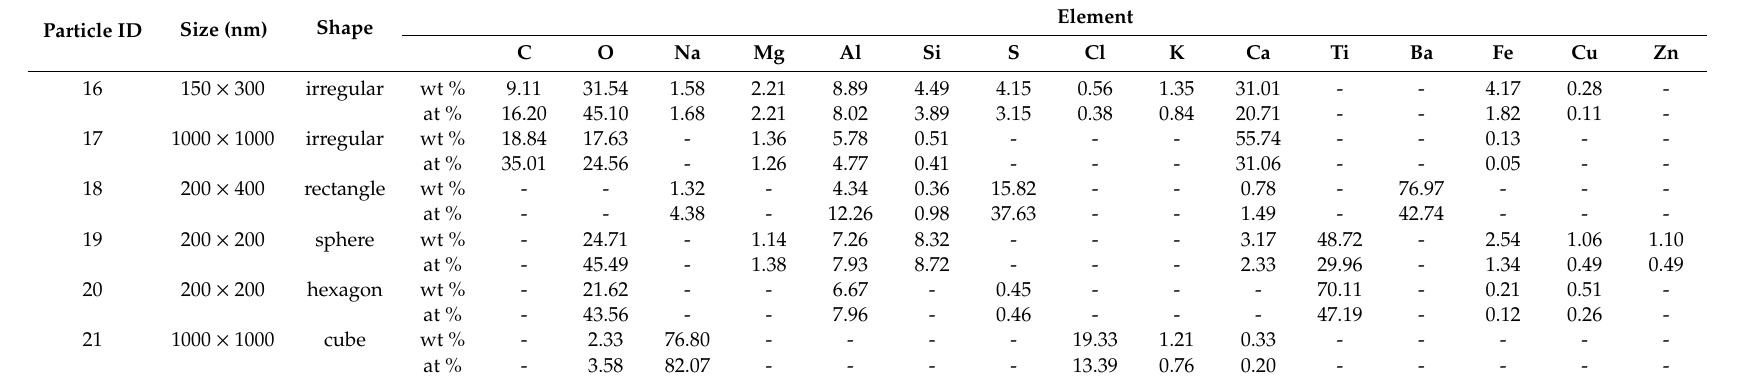
Table 2. Information about Ca-, Ba-, Ti-, and Na-bearing nanoparticles in soils over gold